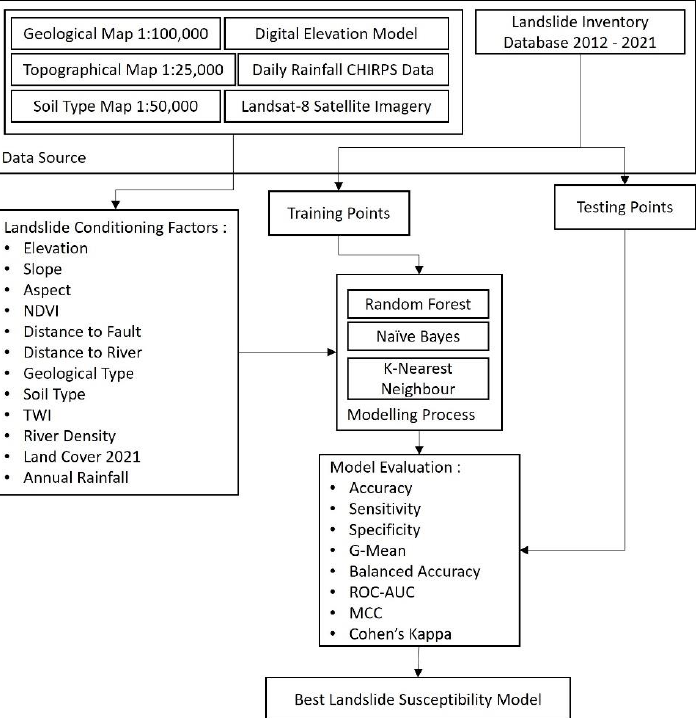
Figure 3. Research workflow of the comparison of landslide susceptibility prediction using RF, NB, and KNN algorithms.